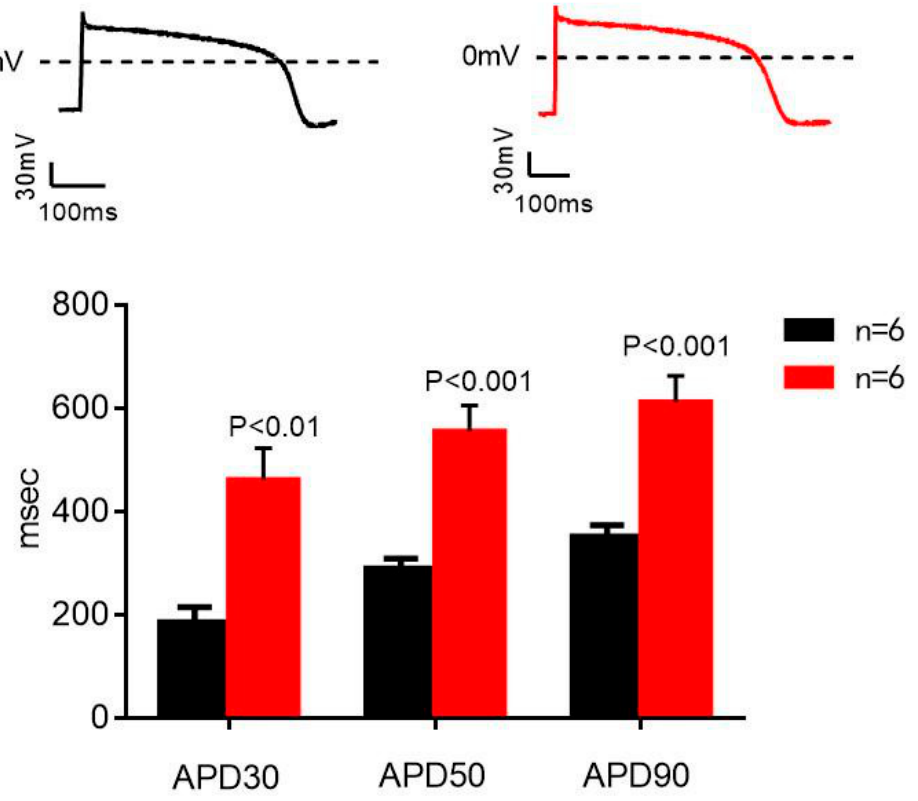
Figure 6. Whole-cell current-clamp recording from hiPSC-CMs. Panel A shows the results of representative AP wave forms recorded in a control and a Long-QT Syndrome (LQTS) hiPSC-CMs. Notice the marked APD prolongation in LQTS hiPSC-CMs. The bar graphs represent the averaged action potential duration at 30% repolarization (APD30) at 50% repolarization (APD50) and at 90% repolarization (APD90) for control and LQTS hiPSC-CMs at a 1-Hz stimulation rate. p values are for the comparison between control and LQTS hiPSC-CMs, with the use of independent samples t -test. Data are means ± SEM for 6 cells in each group (the control subjects and LQTS subjects). (Black: normal; Red: LQTS).